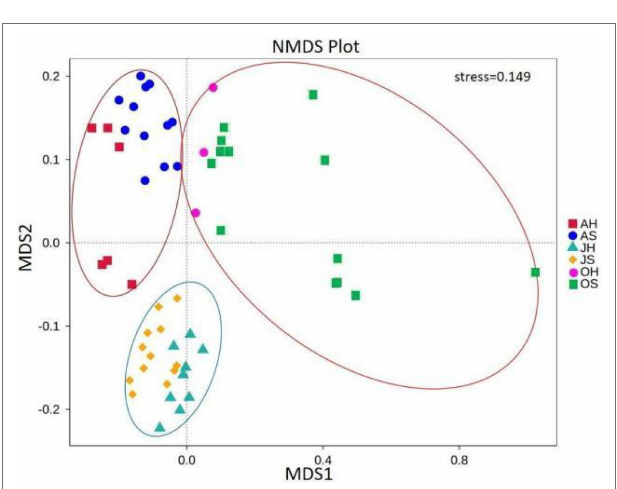
FIGURE 4 | Nonmetric multidimensional scaling analysis using pairwise Bray–Curtis similarity values estimated from operational taxonomic unit (OTU) sequence abundance